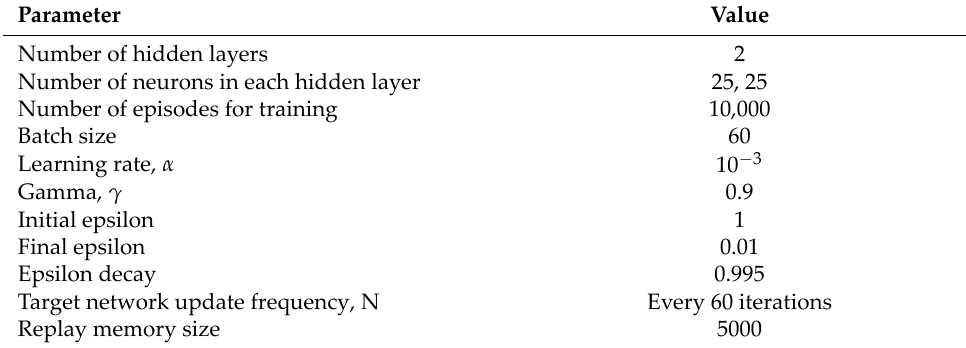
Table 5. Hyperparameters for